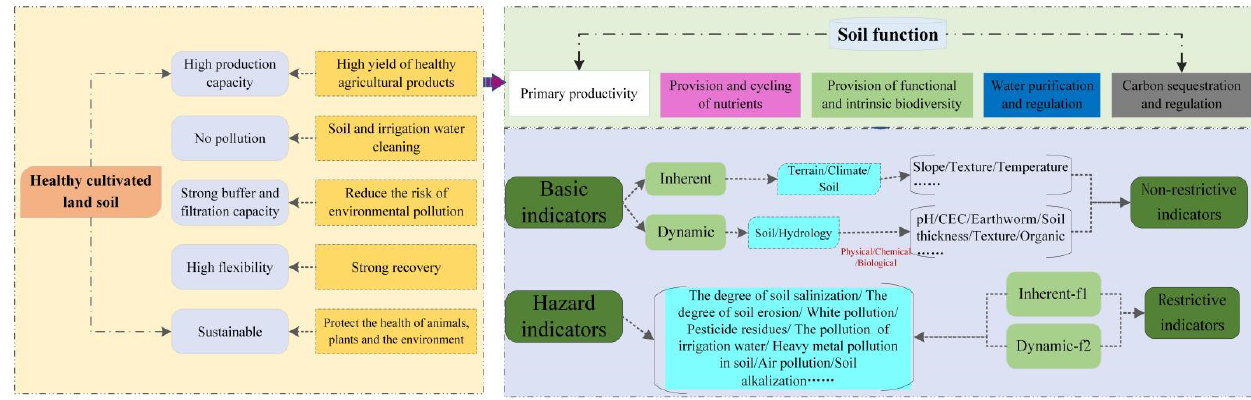
Figure 3. General framework for SH evaluation.